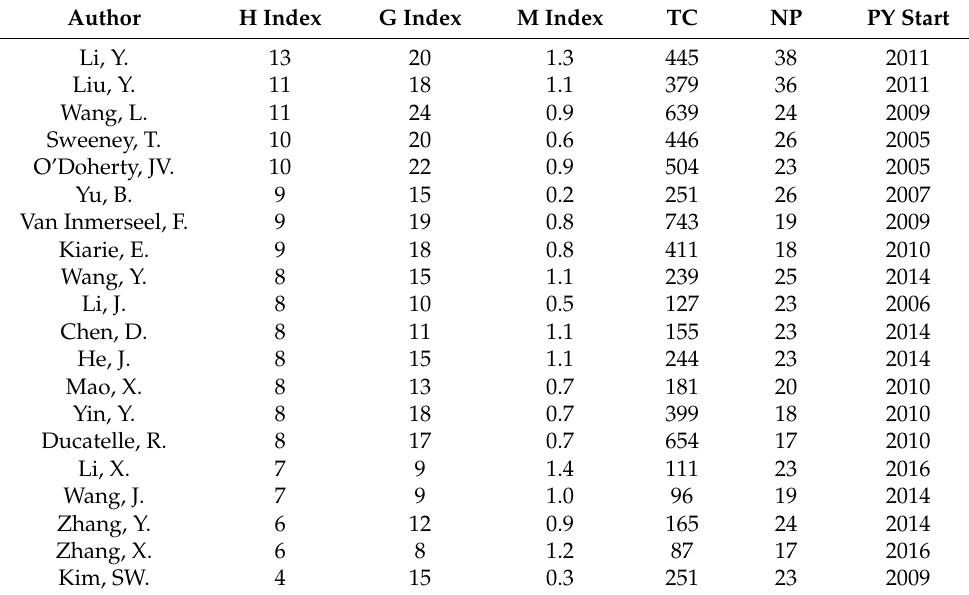
Table 2. Top 20 cited authors on veterinary gut health